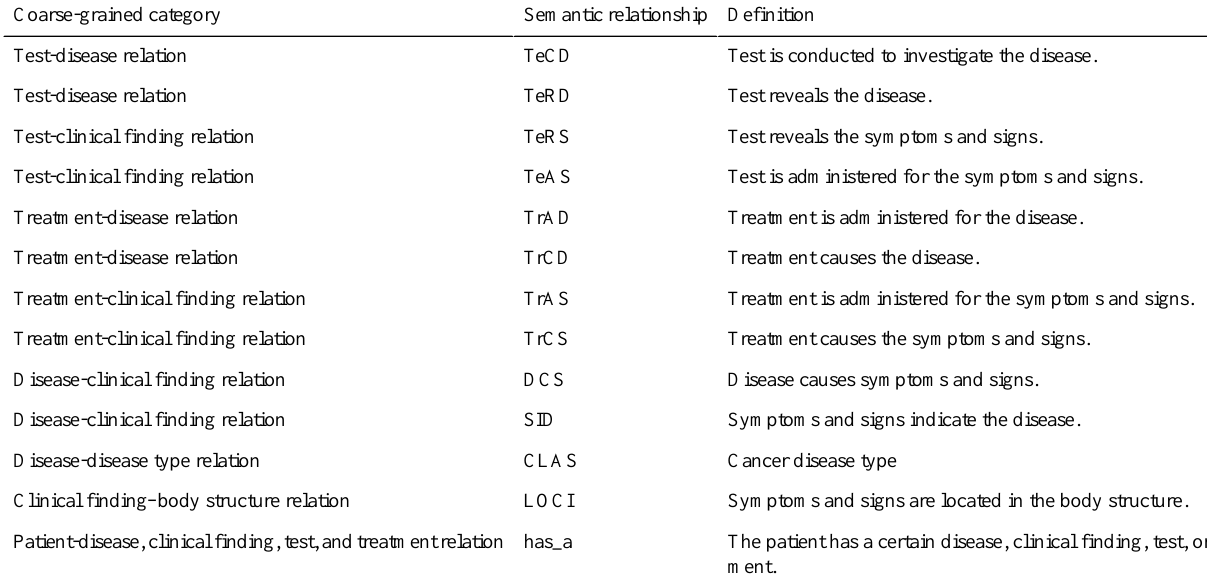
Table 2. Semantic relationships of the digestive system tumor knowledge graph schema.